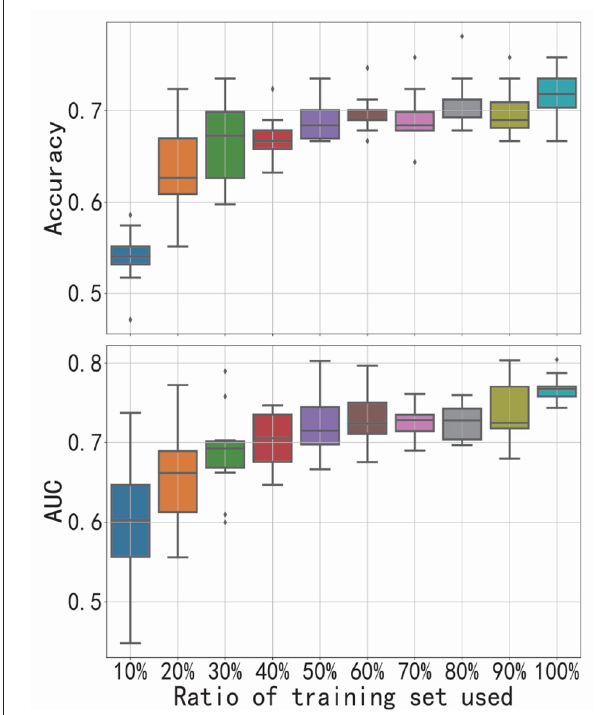
FIGURE 4 | Performance of functional graph discriminative network (FGDN) as the increasing ratio of training set used. Boxplots denote the variant of classification accuracy/area under the curve (AUC) across 10-fold cross-validation.